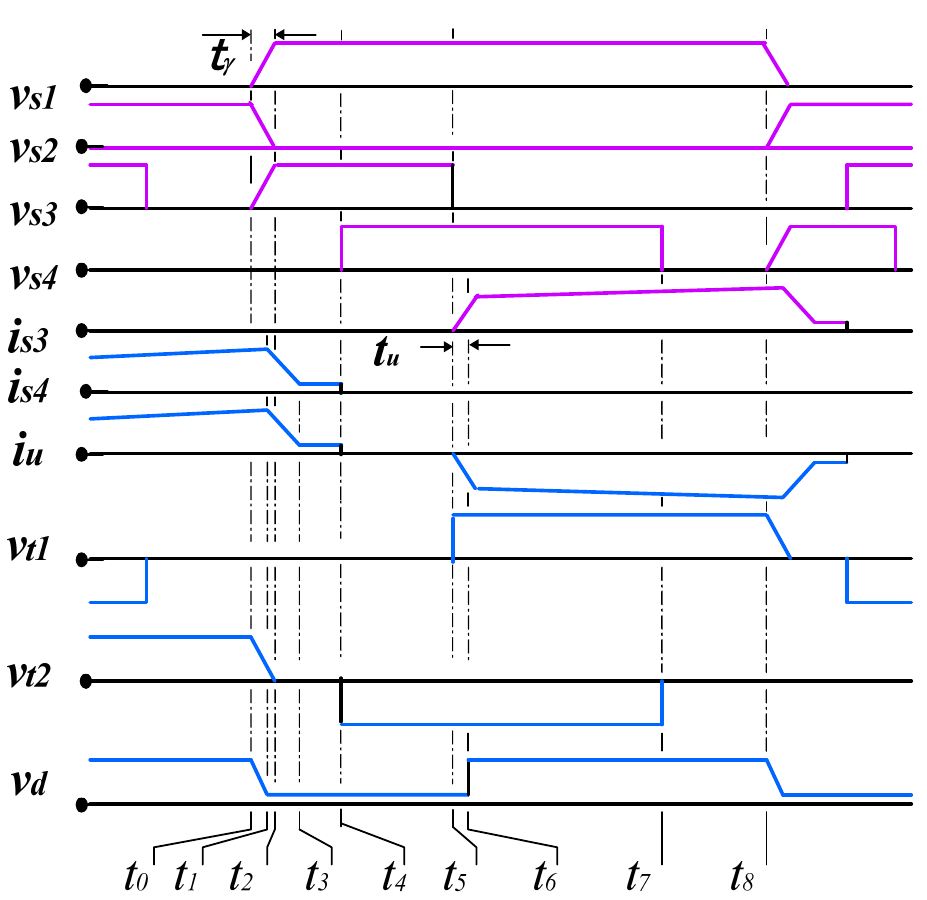
Figure 4. Typical operating waveforms of studied DC-DC power converter.